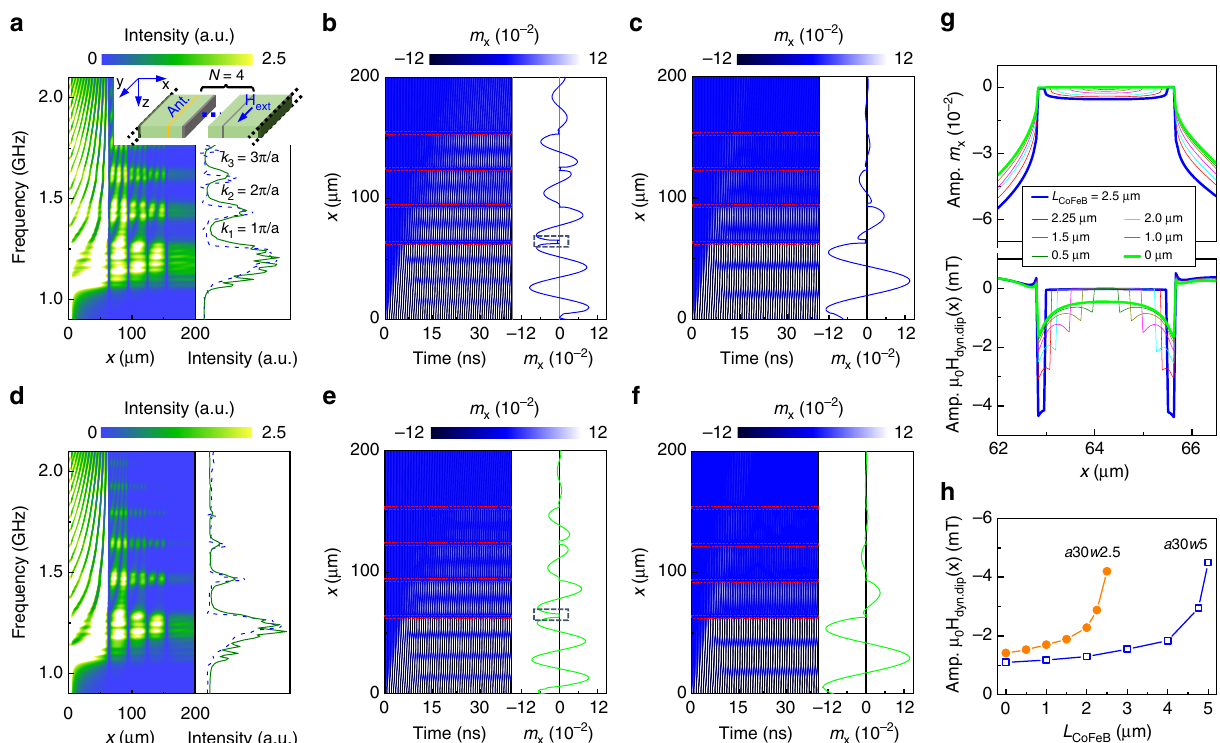
Fig. 6 Micromagnetic simulations. a Spatial distribution of spin-wave intensity in a a 30 w 2.5 bicomponent magnonic crystal with N = 4 CoFeB stripes. The right panel compares simulated (solid green line) and measured (dashed blue line) transmission spectra. The inset illustrates the simulation geometry. b , c Time evolution of spin-wave pro fi les during ac excitation with a sinusoidal magnetic fi eld at a fi xed frequency of b 1.44 GHz and c 1.35 GHz. Spin-wave pro fi les after an excitation time of 30 ns are shown on the right side of the graphs. The system reached steady-state excitation at this time. d – f Similar data as in a – c , but for a a 30 w 2.5 crystal without CoFeB, i.e., discrete YIG stripes separated by airgaps. g Amplitude of m x near the fi rst groove (top panel). The bold blue and green lines correspond to data recorded in the boxes of b , e . The curves show data for a fi xed groove width of w = 2.5 μ m, but different amounts of CoFeB ( L CoFeB ). The bottom panel of g shows the amplitude of the x -component of the dynamic dipolar fi eld for different amounts of CoFeB. h Variation of the dynamic dipolar fi eld near the edge of the fi rst groove ( x = 62.9 μ m in g ) as a function of L CoFeB for a 30 w 2.5 and a 30 w 5